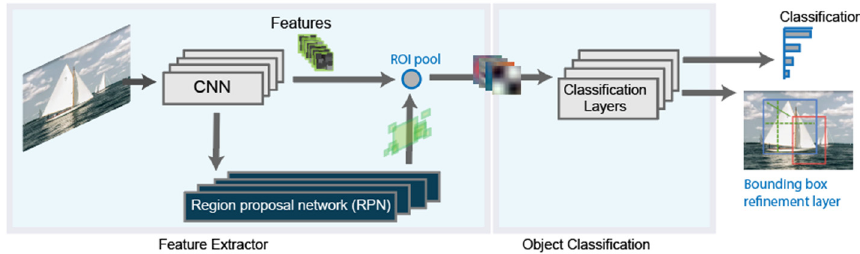
Figure 3. Final schema for the Faster RCNN detector.